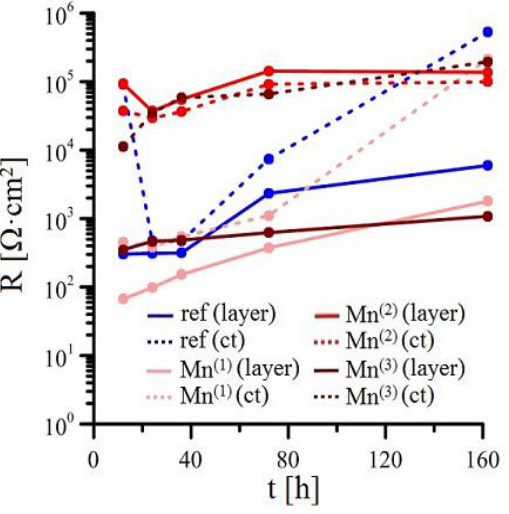
Figure 13. Point evaluation of R (t) EIS spectra for simulated concrete pore solution with graded amount of MnO 4 − .